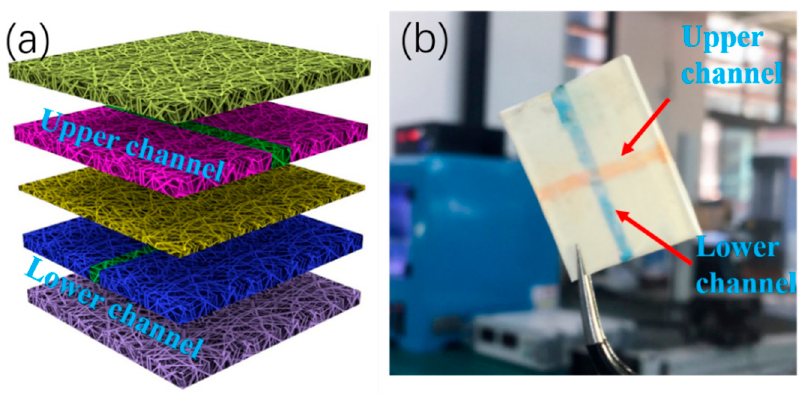
Figure 2. ( a ) Schematic of 3D multilayer channels. ( b ) Dye solution testing.